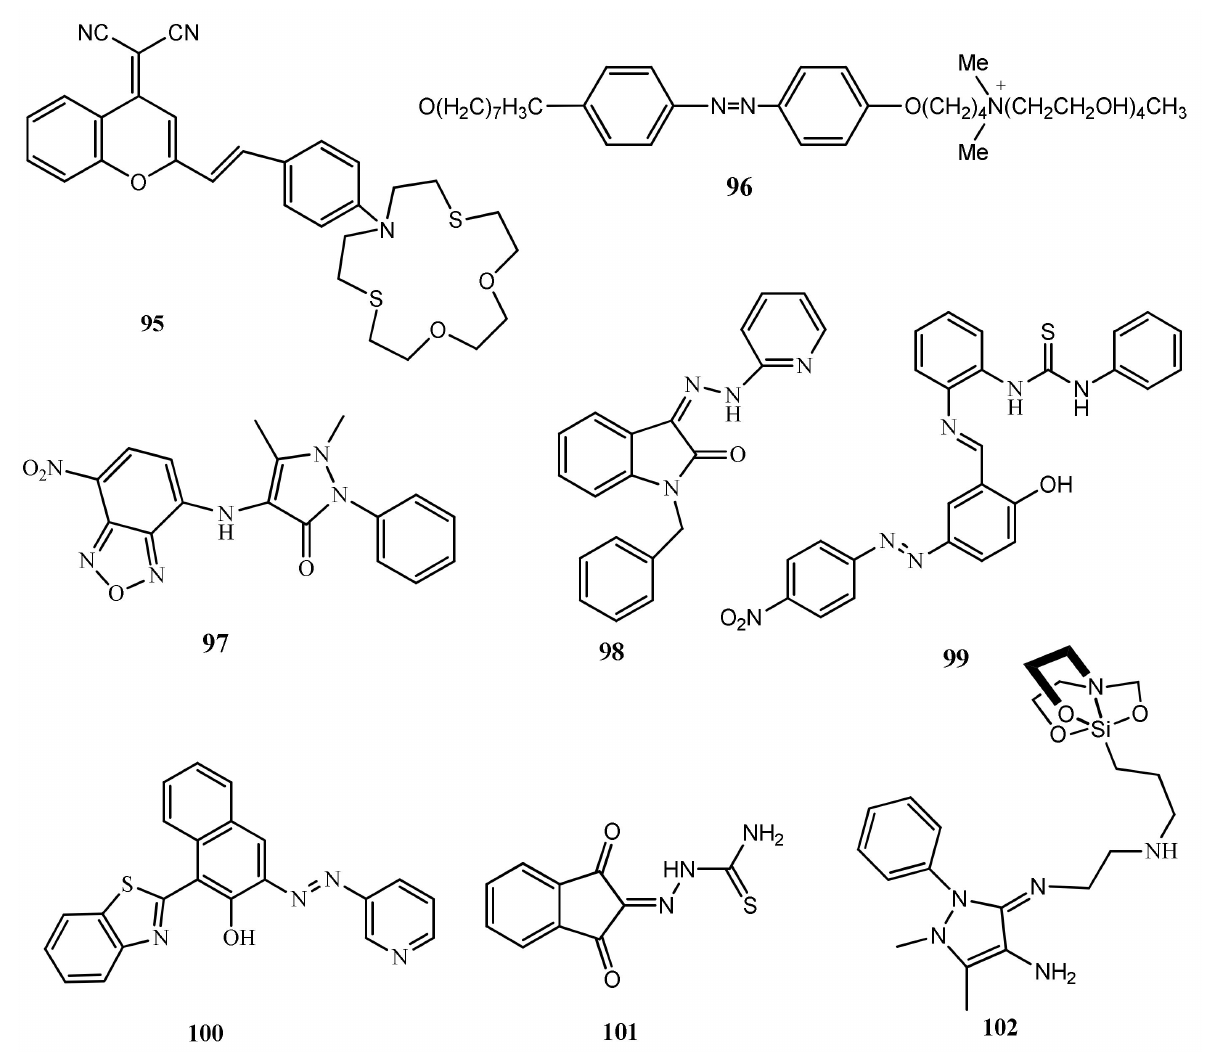
Figure 31. Molecular structures of the sensors 95 to 102